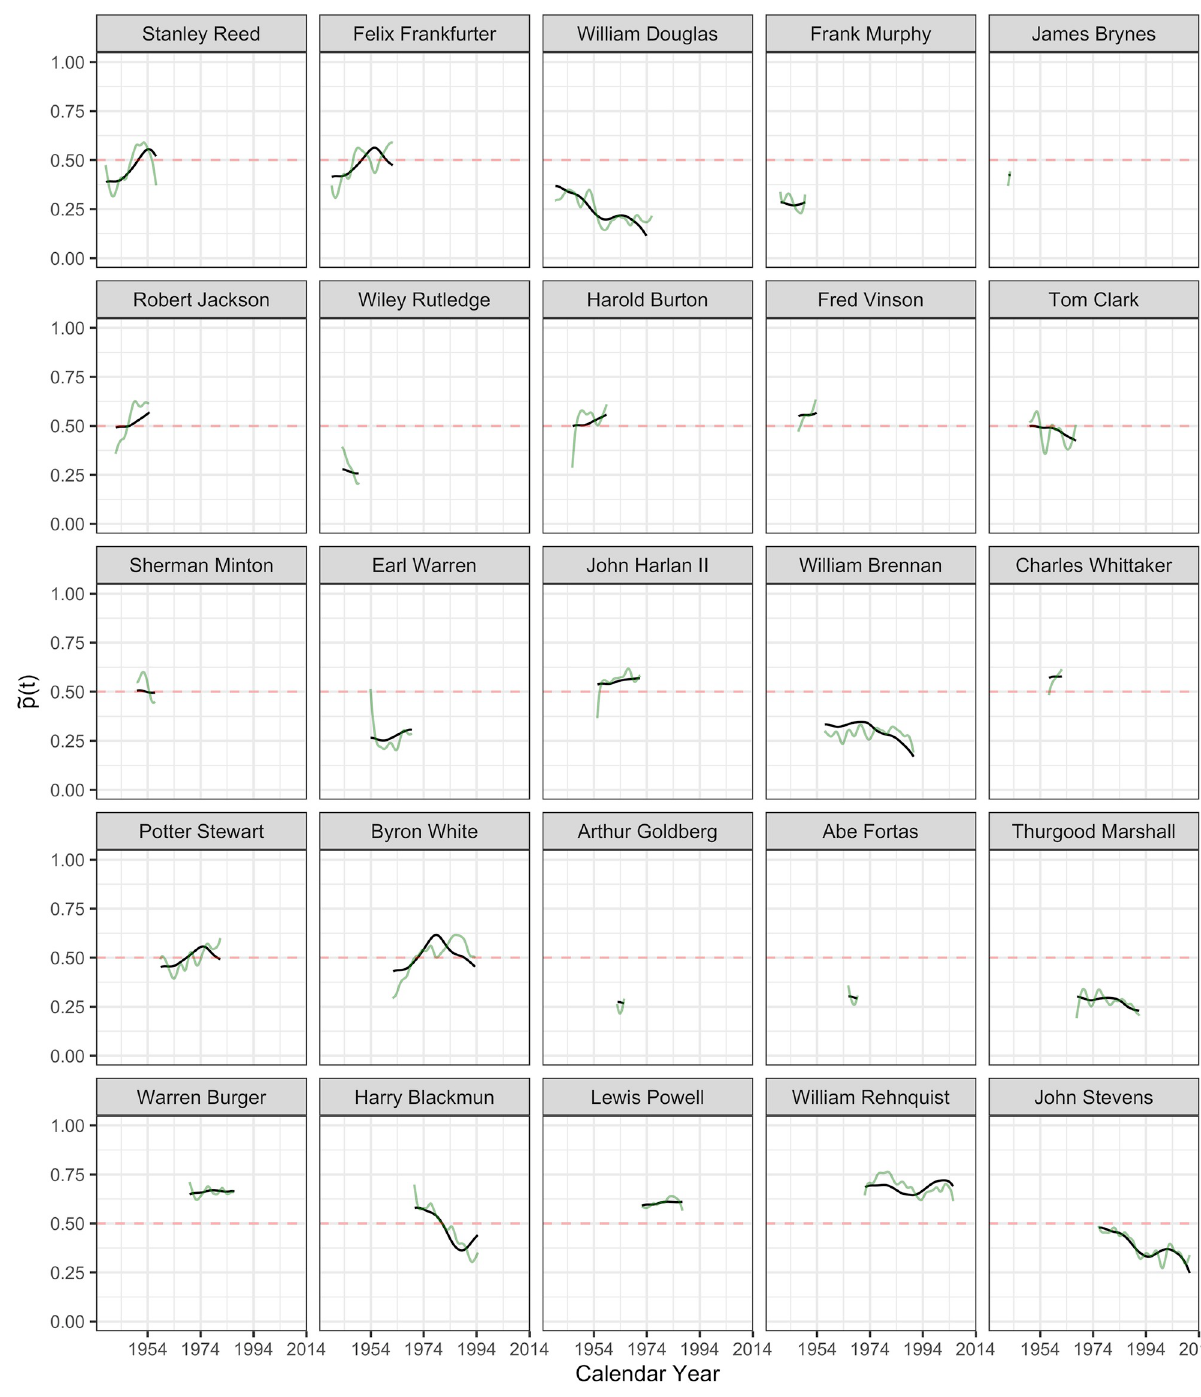
Fig 8. The inferred latent ideology processes ~ p ð t Þ are shown in black and the observed (smoothed) processes ^ p processes ~ p i